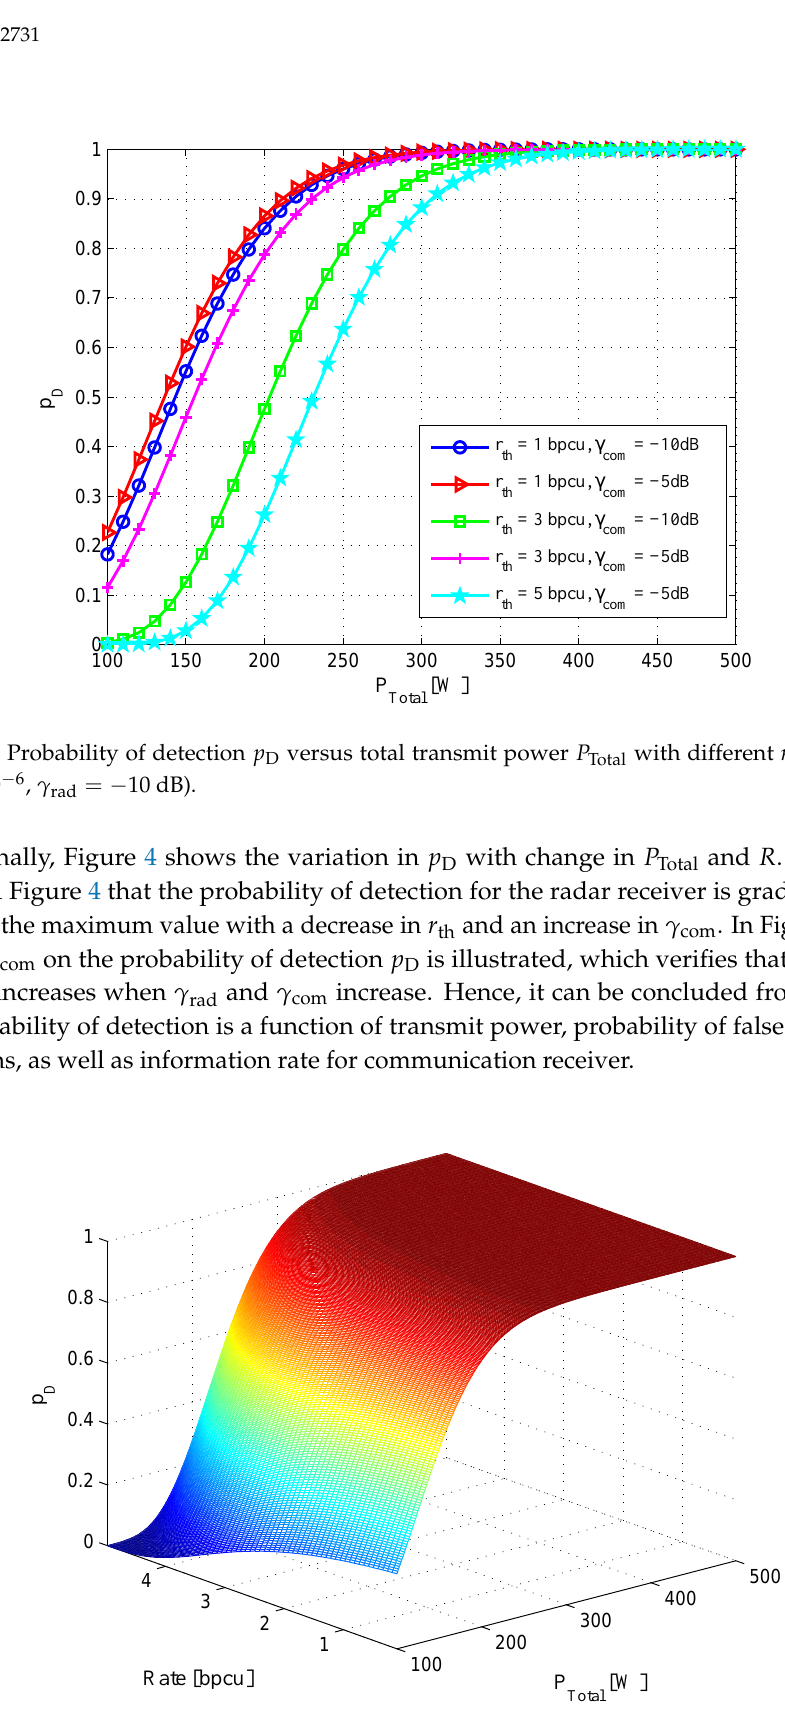
Figure 4. Variation in probability of detection p D with change in total transmit power P Total and information rate R ( δ FA = 10 − 6 , γ rad = − 10 dB, γ com = − 5